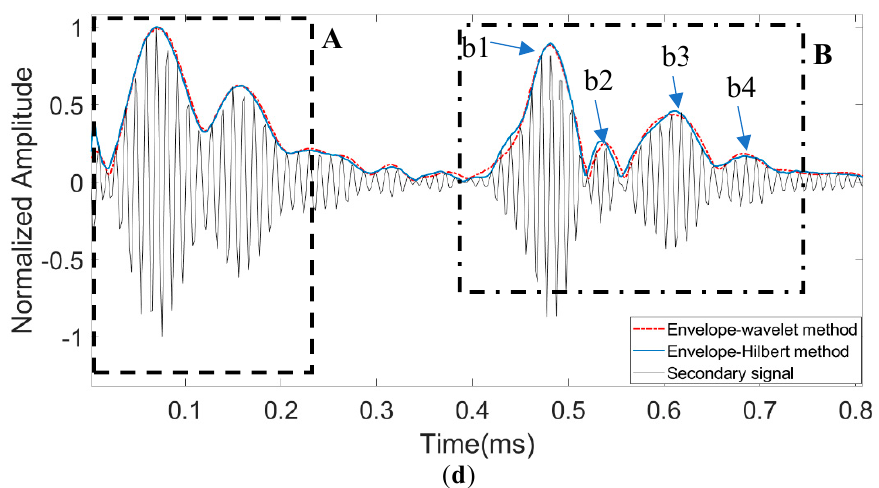
Figure 9. The signal of the 500th record of S1: ( a ) The primary signal; ( b ) The zoomed primary signal with the envelopes extracted by different methods; ( c ) The secondary signal; ( d ) The zoomed secondary signal with the envelopes extracted by different methods with interference.